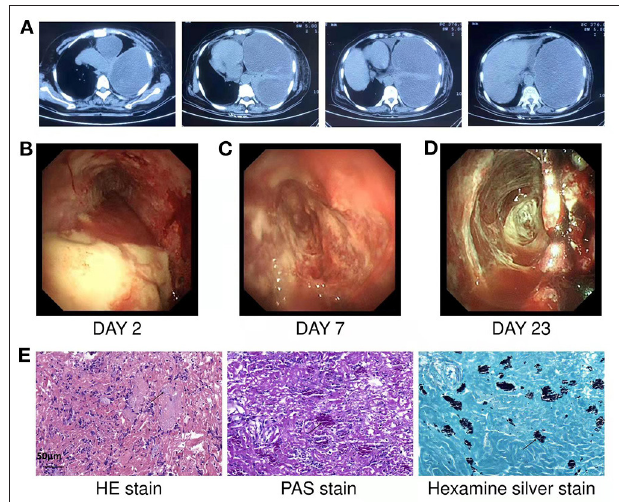
FIGURE 1 | (A) Chest CT showed left pleural effusion with left atelectasis before admission. (B) On the second day of hospitalization, medical thoracoscopy revealed extensive purulent attachment to the parietal pleura, visceral pleura, and diaphragmatic pleura. (C,D) Show the findings of thoracoscopy on the 7th and 23rd days of hospitalization, respectively. After systemic medication, thoracic irrigation and thoracoscopy to clear necrosis and adhesions, the necrosis in the thoracic cavity gradually decreased, the pleural thickening and adhesion gradually decreased. (E) HE staining showed that chronic inflammatory cells infiltrated and aggregated tissue cells in the fibrous connective tissue. The cytoplasm of tissue cells was rich in powdery staining, and there were clustered, oval and light blue fungal spores (black arrows). PAS staining showed spore capsules in pink (black arrows). Silver staining showed spore capsules in black (black arrows) (Scale bar = 50 µ